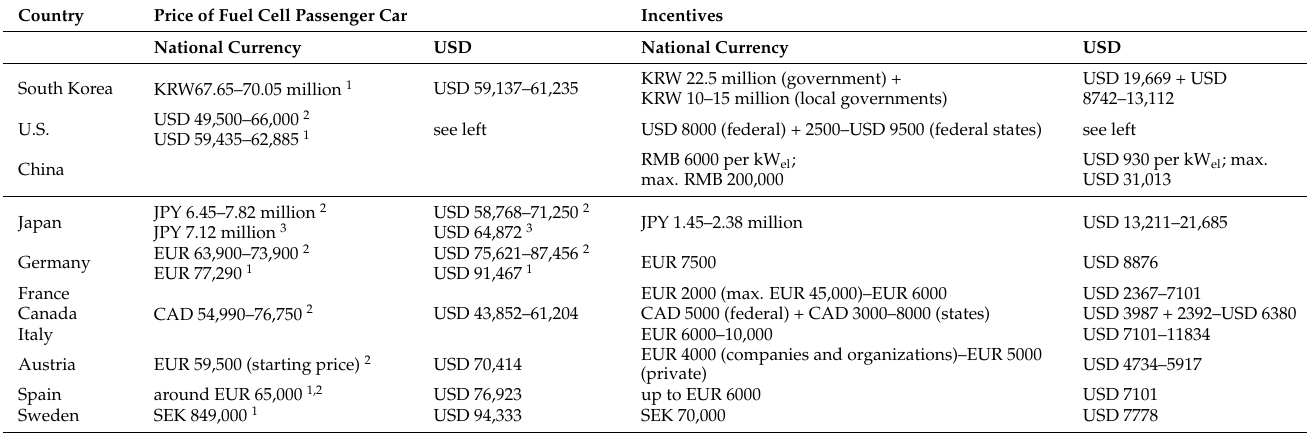
Table 3. Overview of purchasing prices and available incentives for buying a fuel cell passenger car in different countries. See Section 4 for references. Notes: Fuel cell vehicle types: 1 Hyundai Nexo, 2